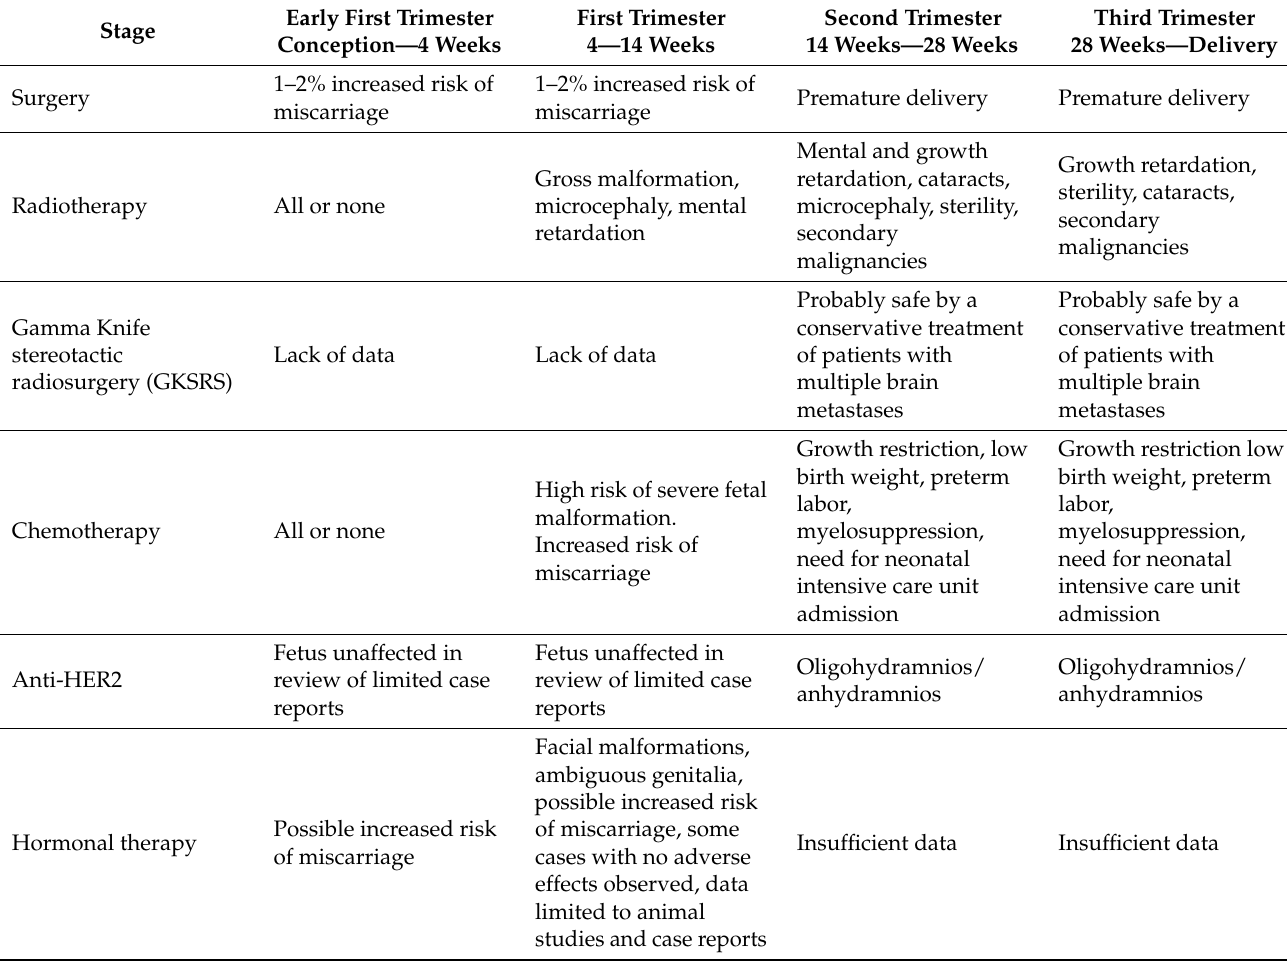
Table 3. Personalization of breast cancer treatment in pregnancy with regard to its stage (adapted according to [46–48]).